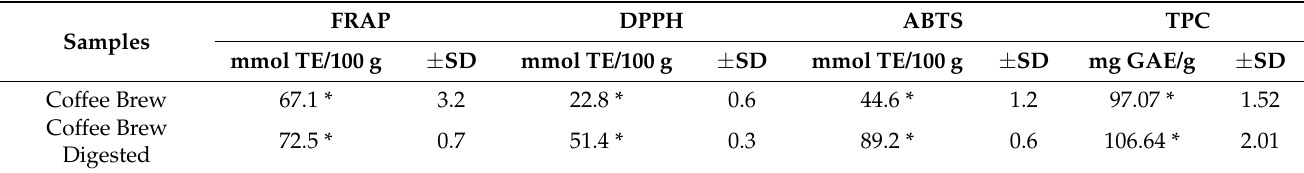
Table 3. TPC and antioxidant capacity evaluated by FRAP, DPPH, and ABTS of the